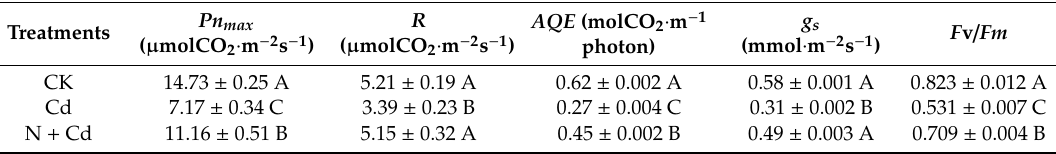
Table 2. E ff ects of cadmium by supplementing nitrogen on photosynthesis and Chl fluorescence in poplar